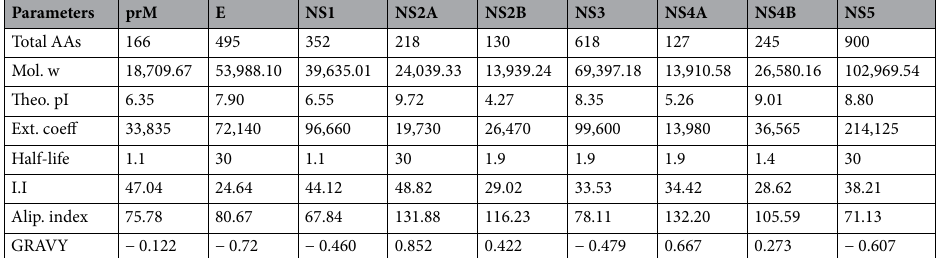
Table 2. Physicochemical properties of the viral protein. https:// web. expasy. org/ cgi- bin/ protp aram/ protp